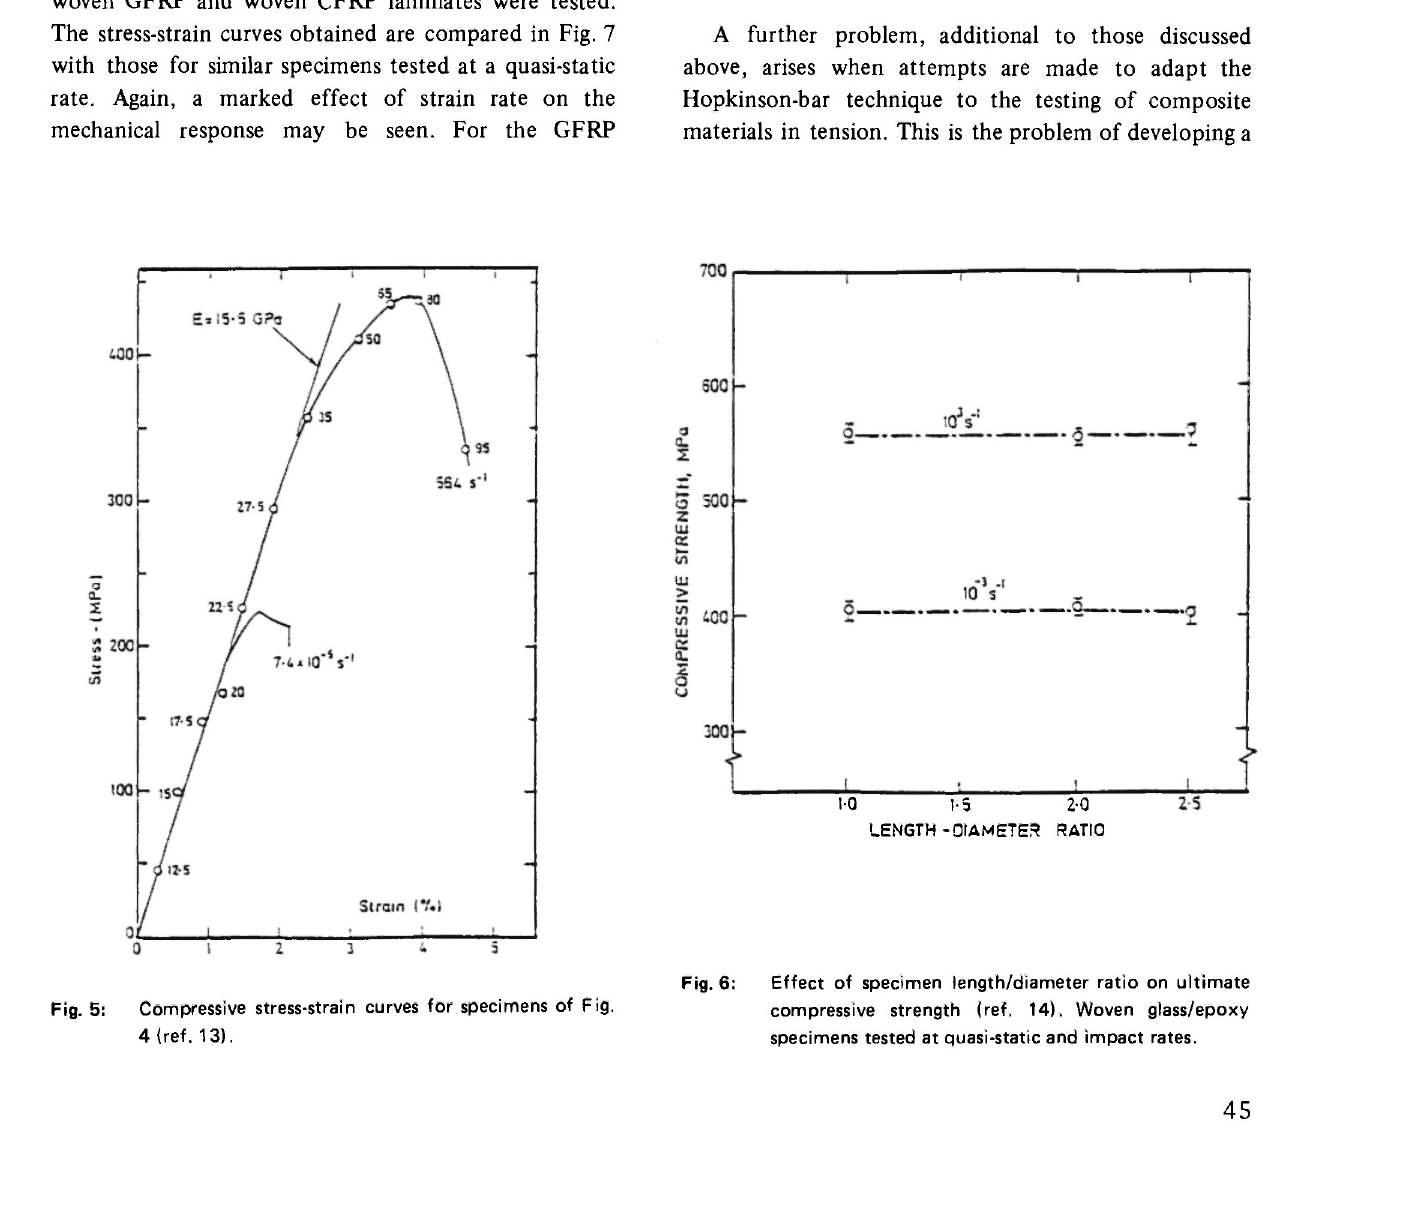
Compressive stress-strain curves for specimens of Fig. 4 (ref. 13).